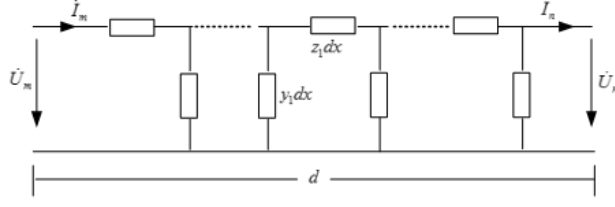
Figure 4. Distributed parameter circuit of a power transmission line.